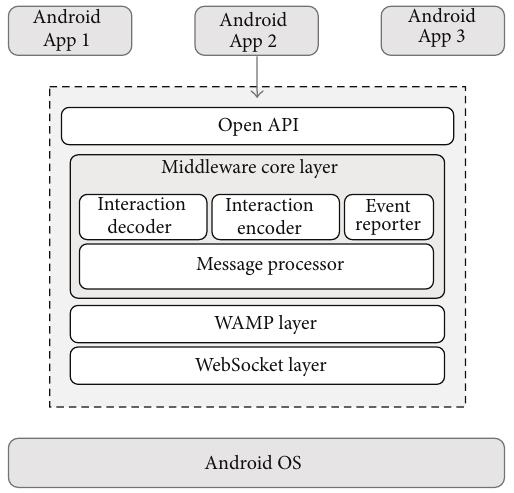
Figure 1: Middleware